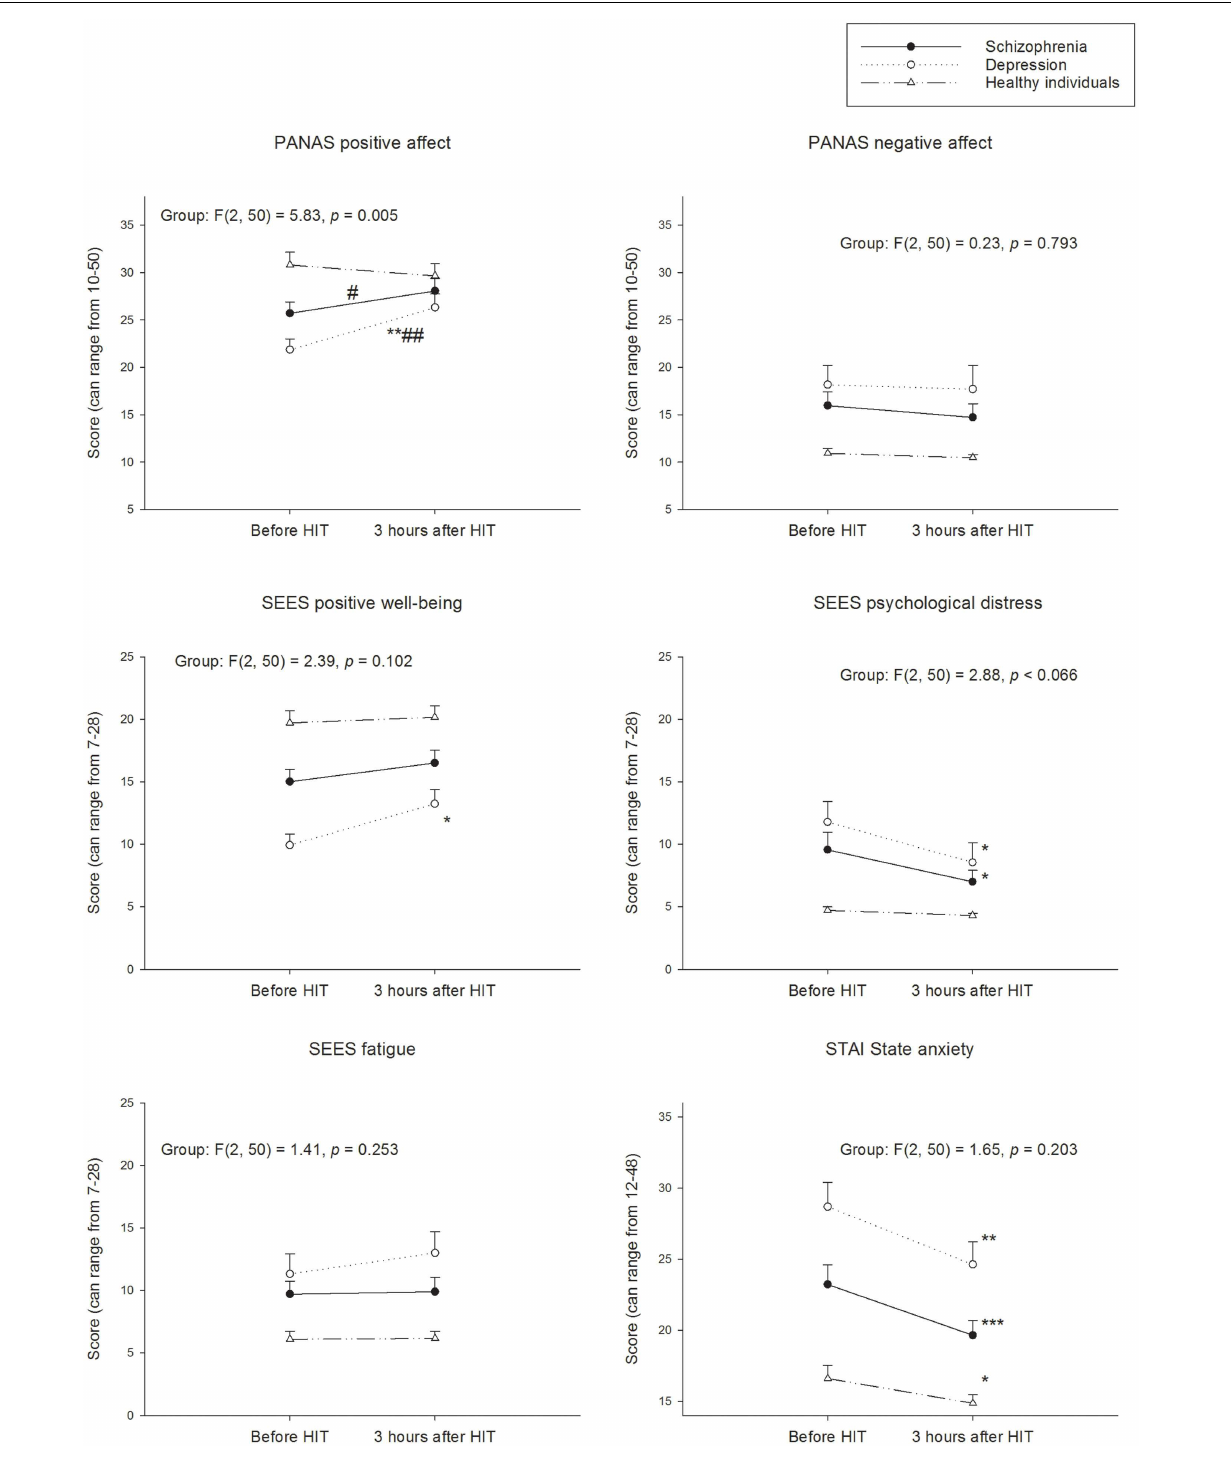
Inventory.Within groups; * p < 0.05; ** p < 0.01; *** p < 0.001 different from before HIT. Between groups; different change from healthy # p < 0.05; ## p <